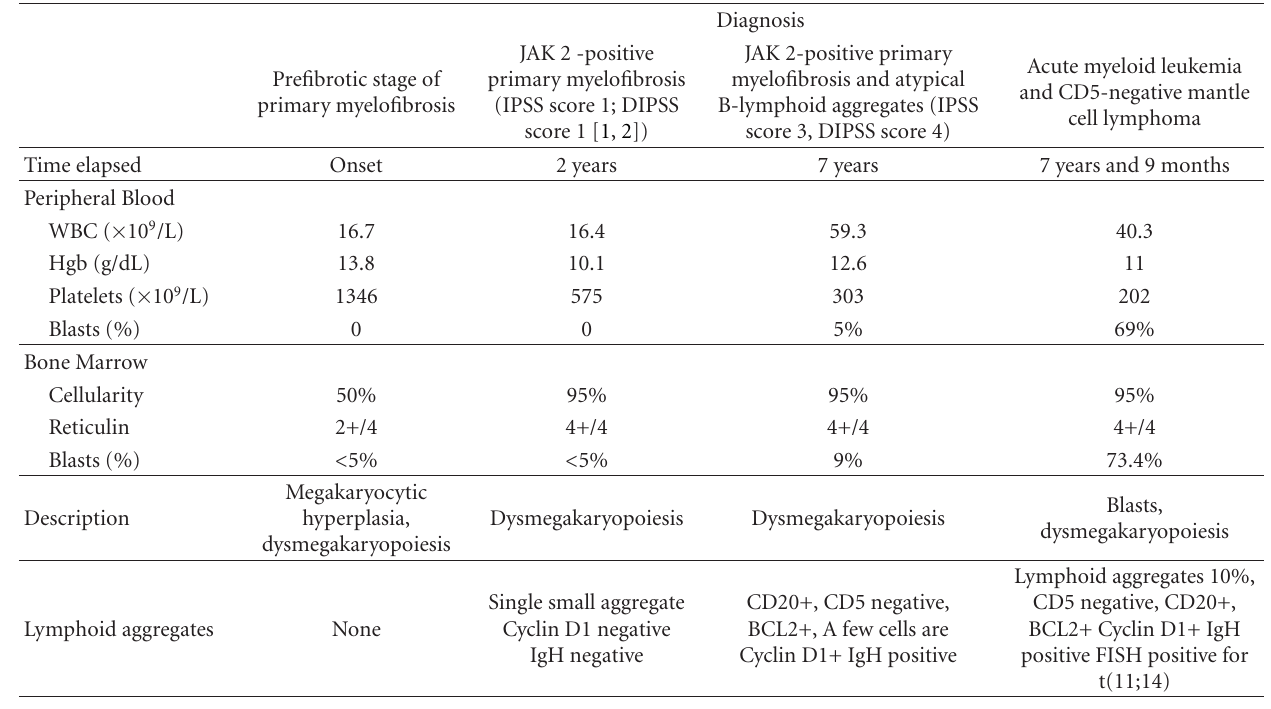
Table 1: Sequential analysis of peripheral blood and bone marrow changes.